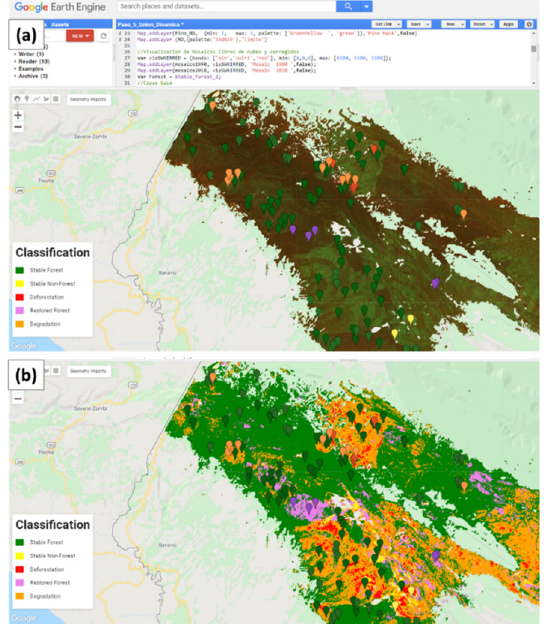
Figure 7. Training samples of 5 land cover classes in GEE: ( a ) samples of land cover change class; ( b ) dynamics of land cover change classification.